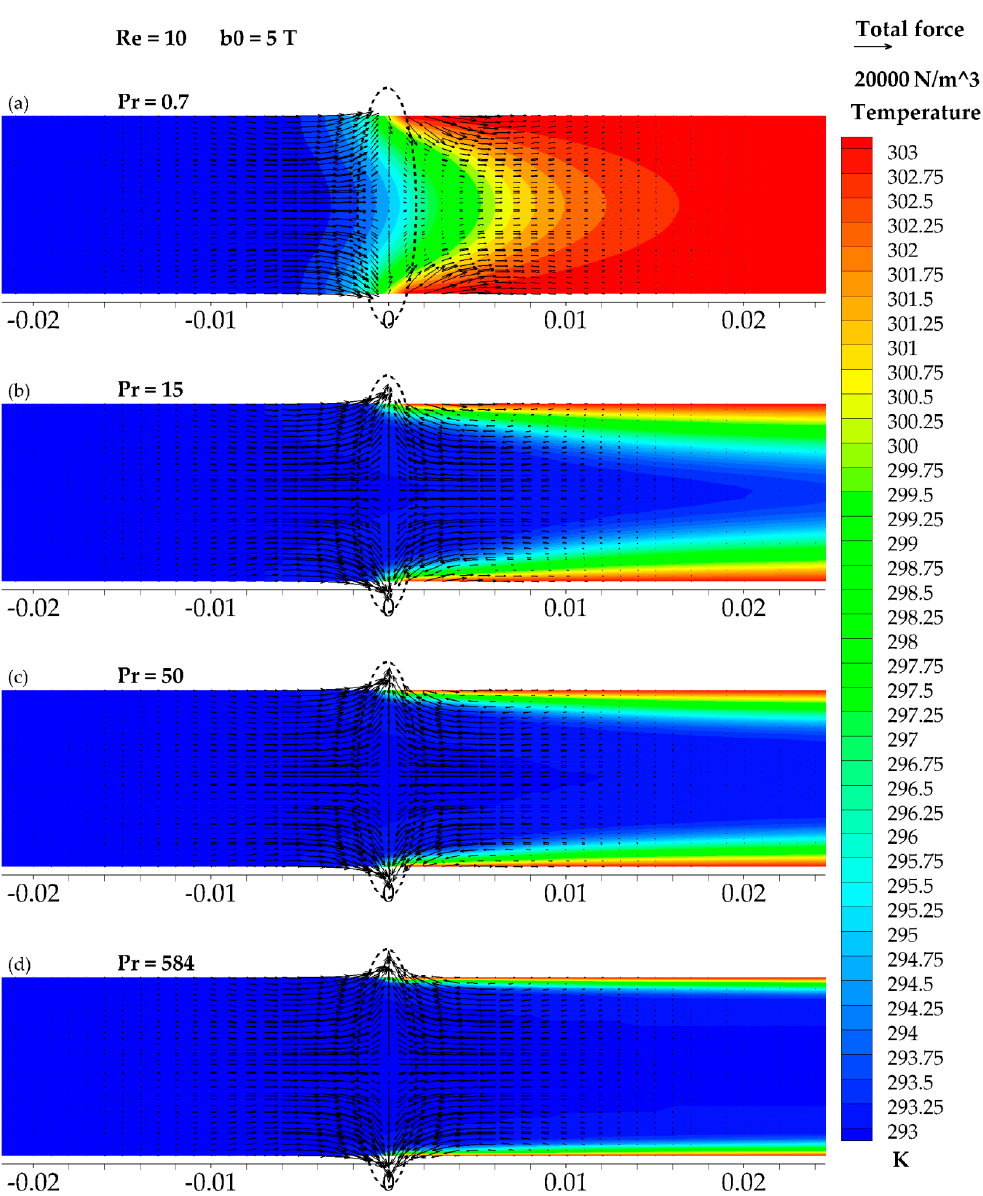
Figure 14. Temperature and total force distribution in the axial cross-section at Re = 10 and b 0 = 5 T: ( a ) Pr = 0.001, ( b ) Pr = 15, ( c ) Pr = 50, ( d ) Pr = 584.